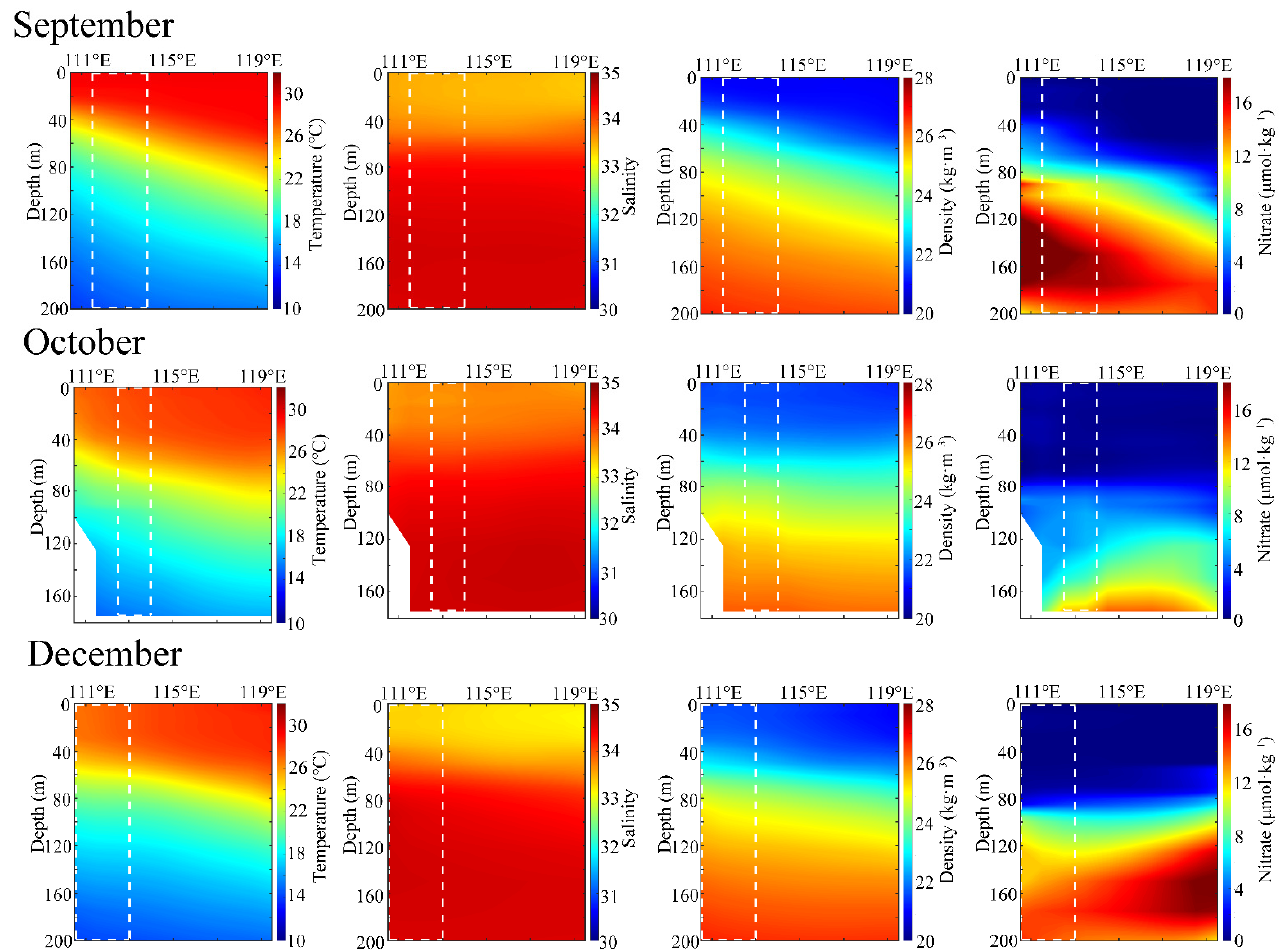
Figure 13. Vertical distribution of temperature, salinity, density and nitrate in September, October and November of WOA18. Along the latitude average, the white dotted line represents the black box area of Figure 1.